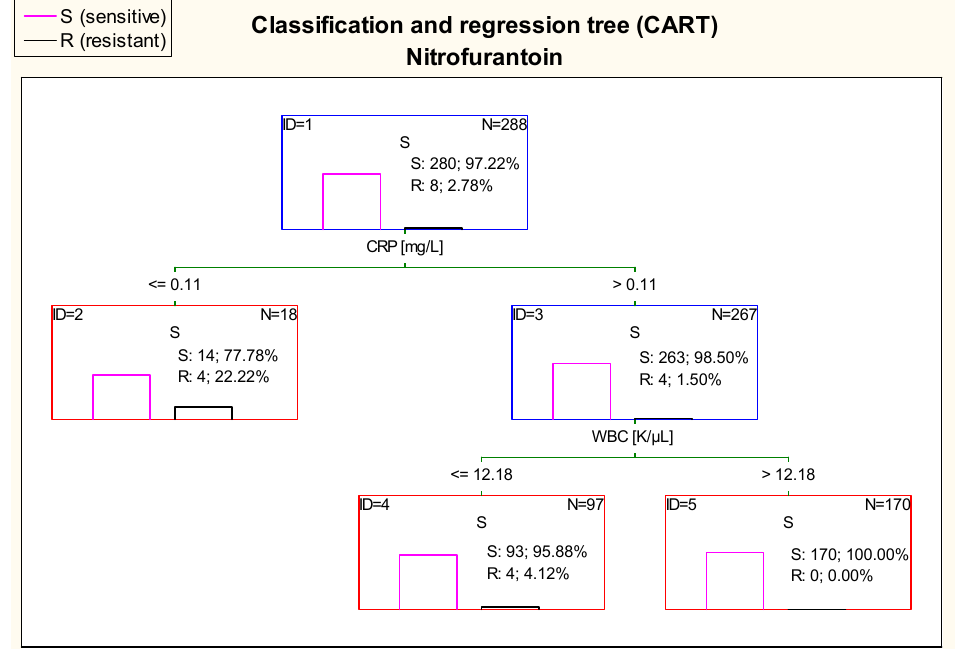
Figure 15. Classification and regression tree (CART) for resistance of Escherichia coli to nitrofurantoin created on the basis of inflammatory